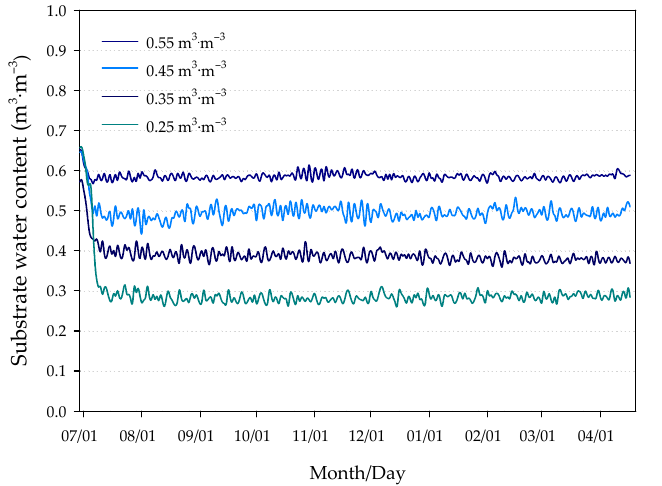
Figure 2. Substrate volumetric water content of 1-year-old cymbidium “Hoshino Shizuku” as maintained by a sensor-based automated irrigation system with coir dust substrate for 42 weeks. Plants were irrigated when the substrate water content reading of the FDR sensors dropped below each 0.25, 0.35, 0.45, and 0.55 θ thresholds (m 3 ·m − 3 ).